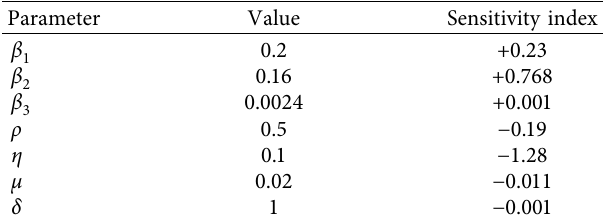
Table 1: Computed sensitivity index